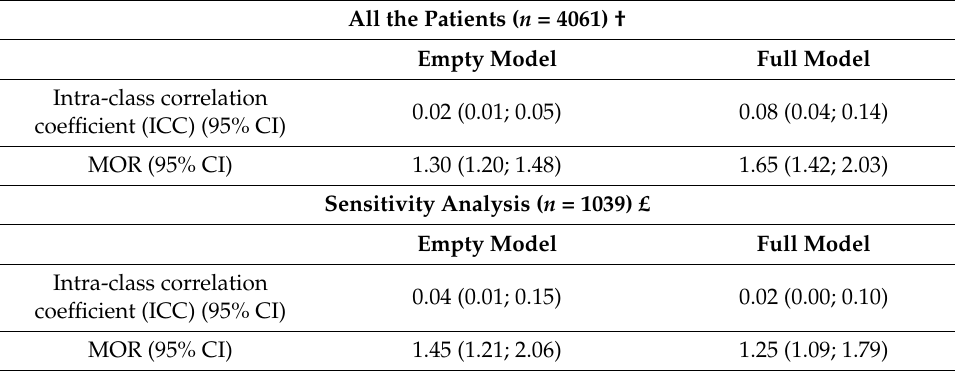
Table 5. Estimates of the inter-physician variability for improvement in disability.